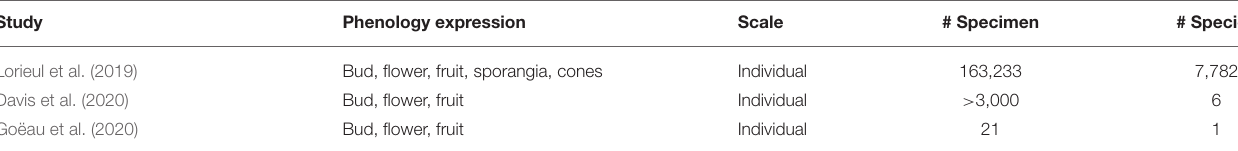
TABLE 2 | Overview of studies that used herbarium materials for phenological study with DL methodology.